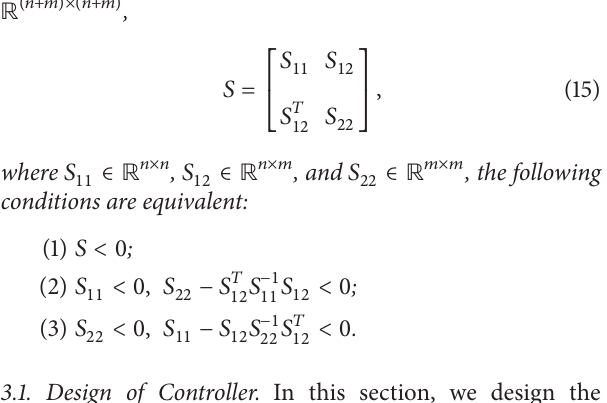
Figure 1: The closed-loop systems with input